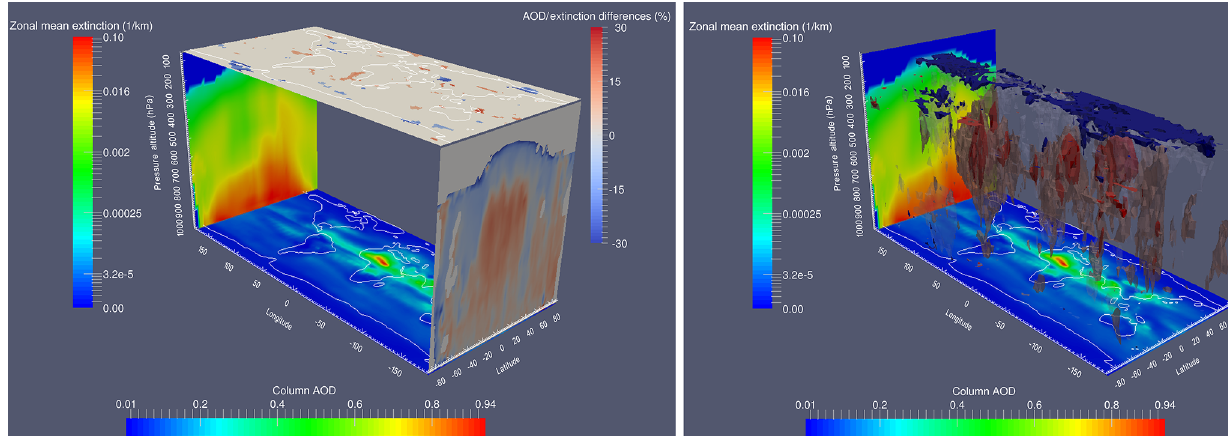
Figure 5. 3-D visualisation of aerosol extinction and the influence of LNO x emissions. The left panel shows a map of the vertically integrated column AOD (at 550nm) when lightning emissions are included (floor plane). The ceiling depicts the relative differences of the integrated column AOD between the simulation with lightning emissions minus the simulation without lightning LNO x , with the full set-up serving as a reference. The back panel displays the zonal average aerosol extinction (in 1km at 550nm) of the full simulations (Please note the logarithmic scale.). The front panel depicts relative percentage differences due to NO x emissions from lightning. White areas mark regions without statistical significance. The right panel also shows AOD (floor) and zonal mean extinction (rear panel), and additionally 3-D isosurfaces in the centre of the box represent the + 10% (pale red) and + 20% (dark red) of the enhanced extinction due to active LNO x emissions, whereas the − 10% (pale blue) and − 20% (dark blue) isosurfaces mark regions in which the emissions result in a reduction of the